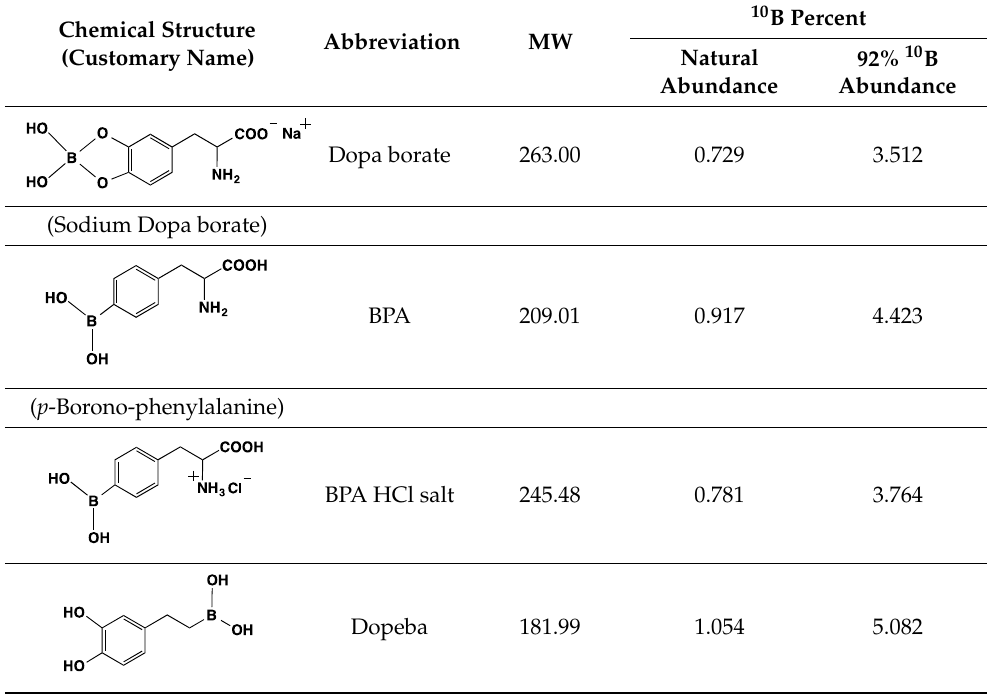
Table 3. Chemical structure and property of synthetic Boron compounds related to Dopa. Dopeba: